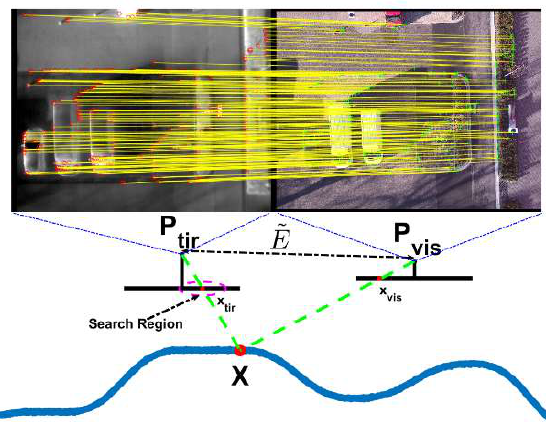
Figure 1. Diagram of multimodal image matching with epipolar constraint (see text for